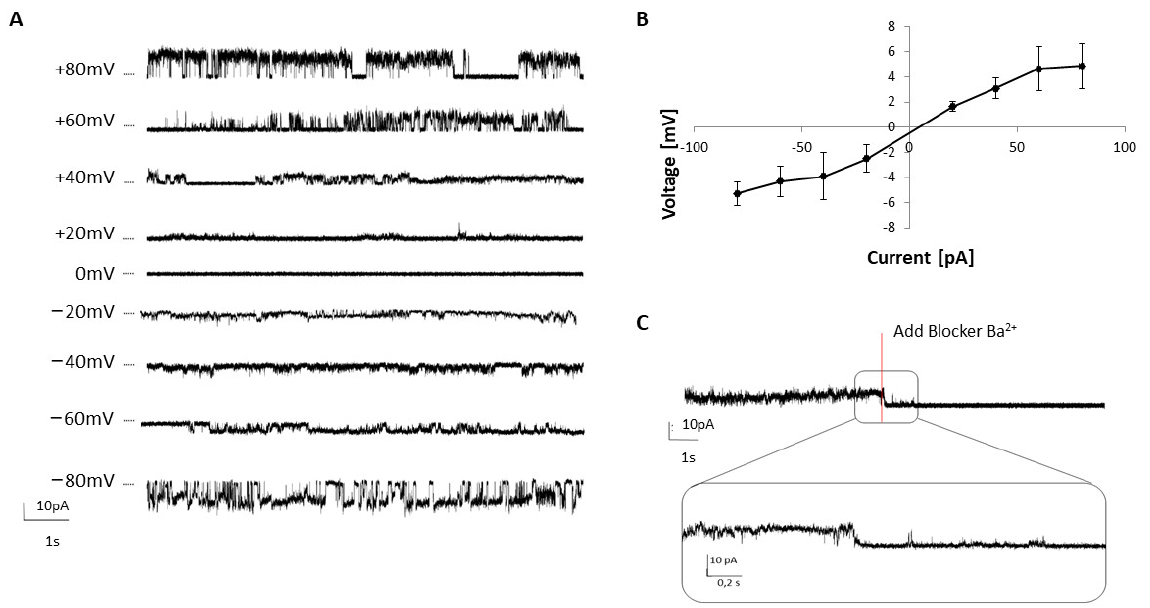
Figure 3. Electrophysiological characterization of cell-free synthesized TREK-2. TREK-2 was synthesized in Sf 21 lysate and the vesicular fraction was tested by planar lipid bilayer-based electrophysiology (DPhPC lipids and 150 mM KCl in 20 mM Hepes buffer). ( A ) Single-channel recordings of TREK-2 at different voltages (−80 mV to −80 mV). ( B ) Voltage–current ratio at the applied conditions. ( C ) Blocking of a functional TREK-2 channel with 5 mM Ba 2+.